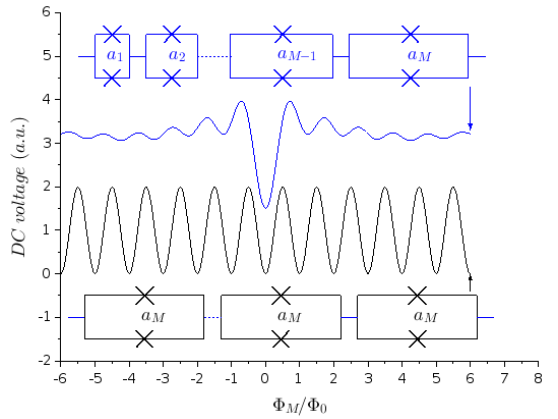
Figure 2. Transfer function made with series arrays of SQUIDs. Top curve: non-periodic with incommensurate SQUID areas; bottom curve: periodic with equal SQUID areas ( Φ M refers to the flux coupled to the SQUIDs with area a M ). The curves are shifted vertically for